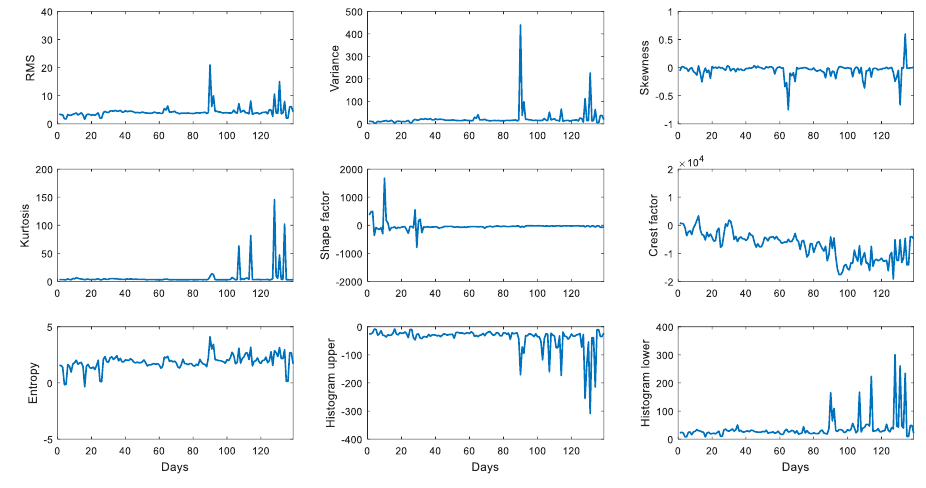
Figure 4. Time-domain feature extraction results (139 days).